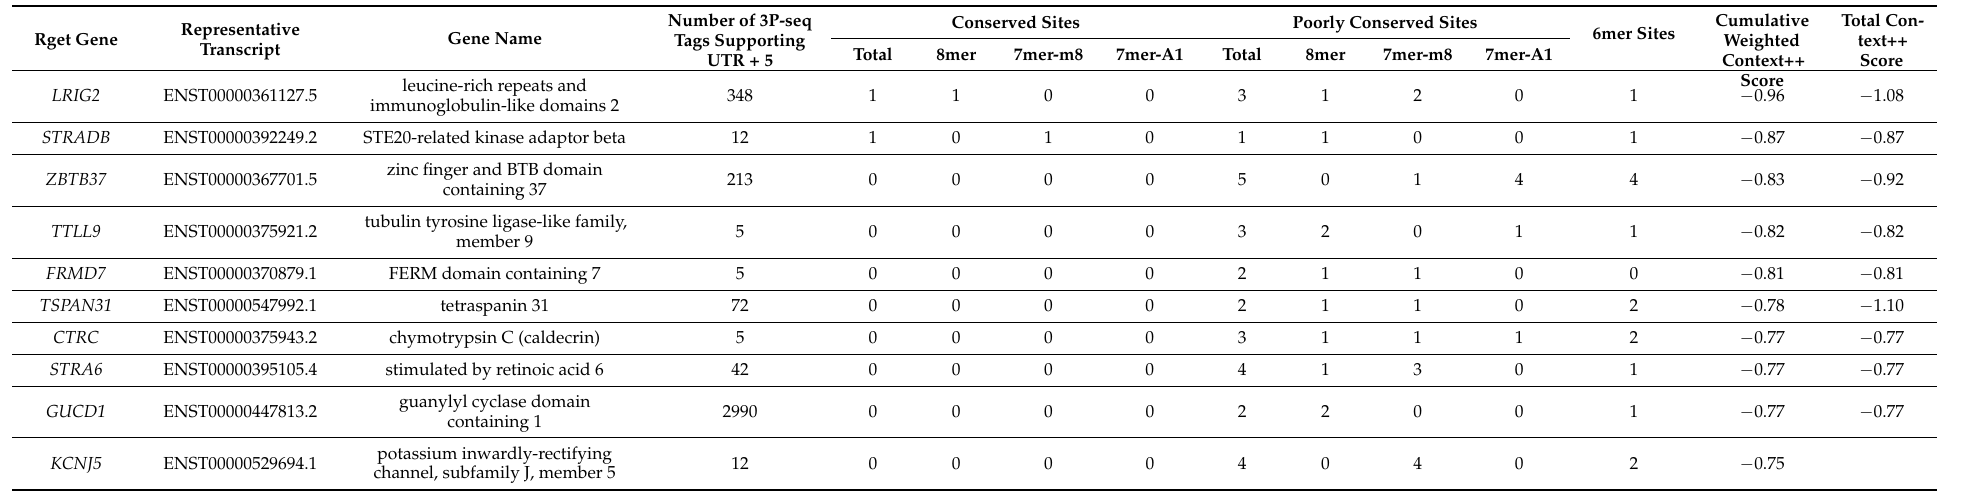
Table 4. Top predicted targets of